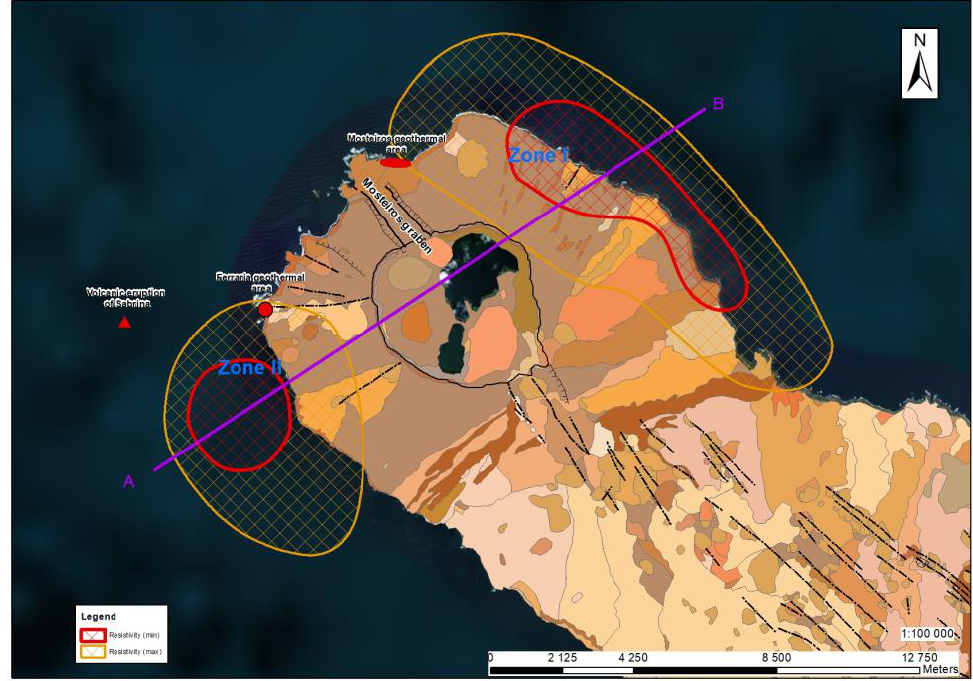
Figure 2. Sete Cidades volcano: geology, tectonics, and hydrothermal features. Zone I: Mosteiros Geothermal Reservoir; Zone II: Ferraria Geothermal Reservoir. Minimum and maximum areas are illustrated (see Table 2).